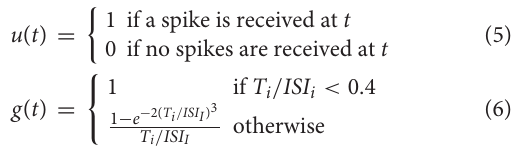
number of neurons in the spinal cord populations, as well as parameters for the synaptic connections are taken from Moraud et al. (2016), with the exception of the synaptic weights of the monosynaptic connections, which have been significantly lowered (see Supplementary Material ). The parameters from the muscle spindle models are taken from Mileusnic et